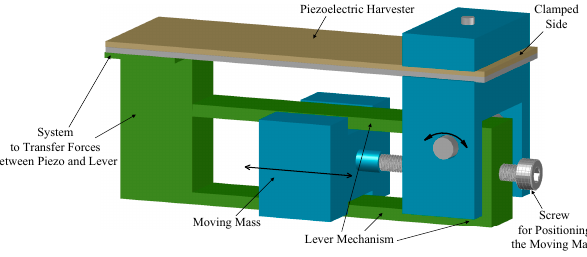
Figure 24. Schematic representation of the variable center of gravity based MTT proposed in [44].